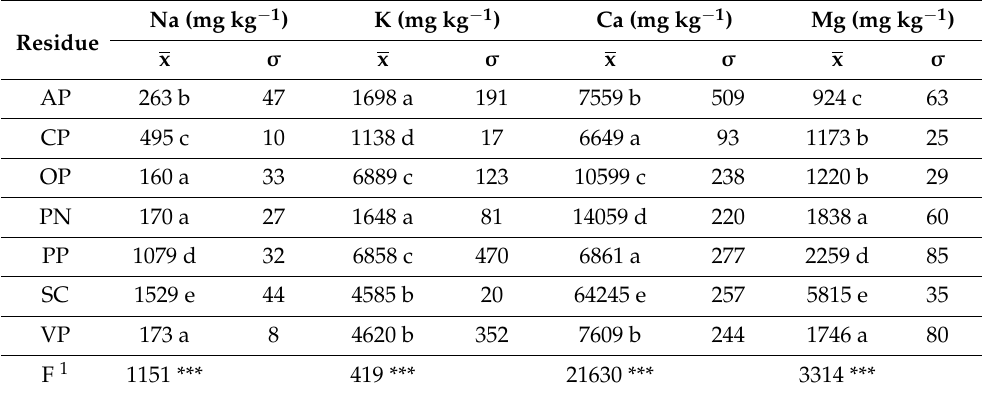
Table 3. Elemental macronutrient composition, average content (x) and standard deviation ( σ ) for each